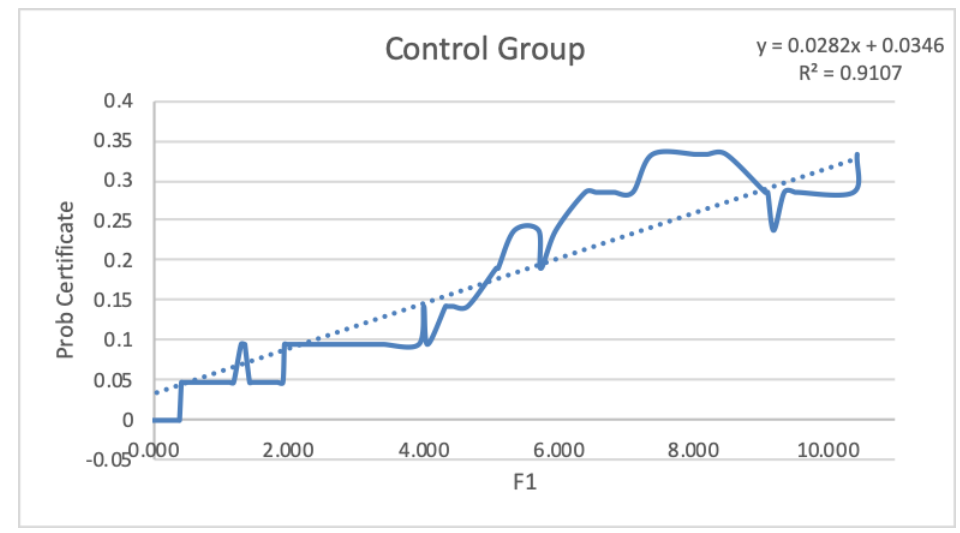
Figure 7. The plot of Certificate probability vs. F1 with the linear fit for the control group with a sample size of the probability estimate n =